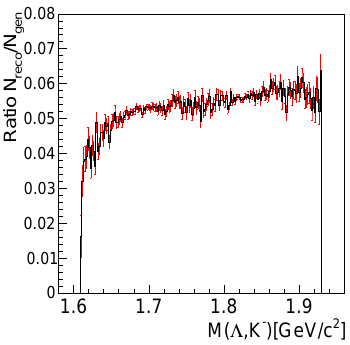
Table 4. Fit results for Ξ ∗ and Ξ